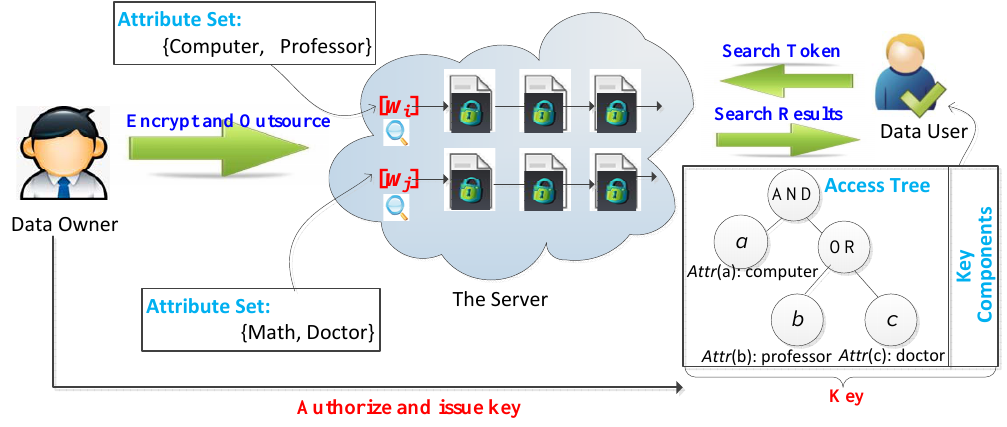
Figure 2. System